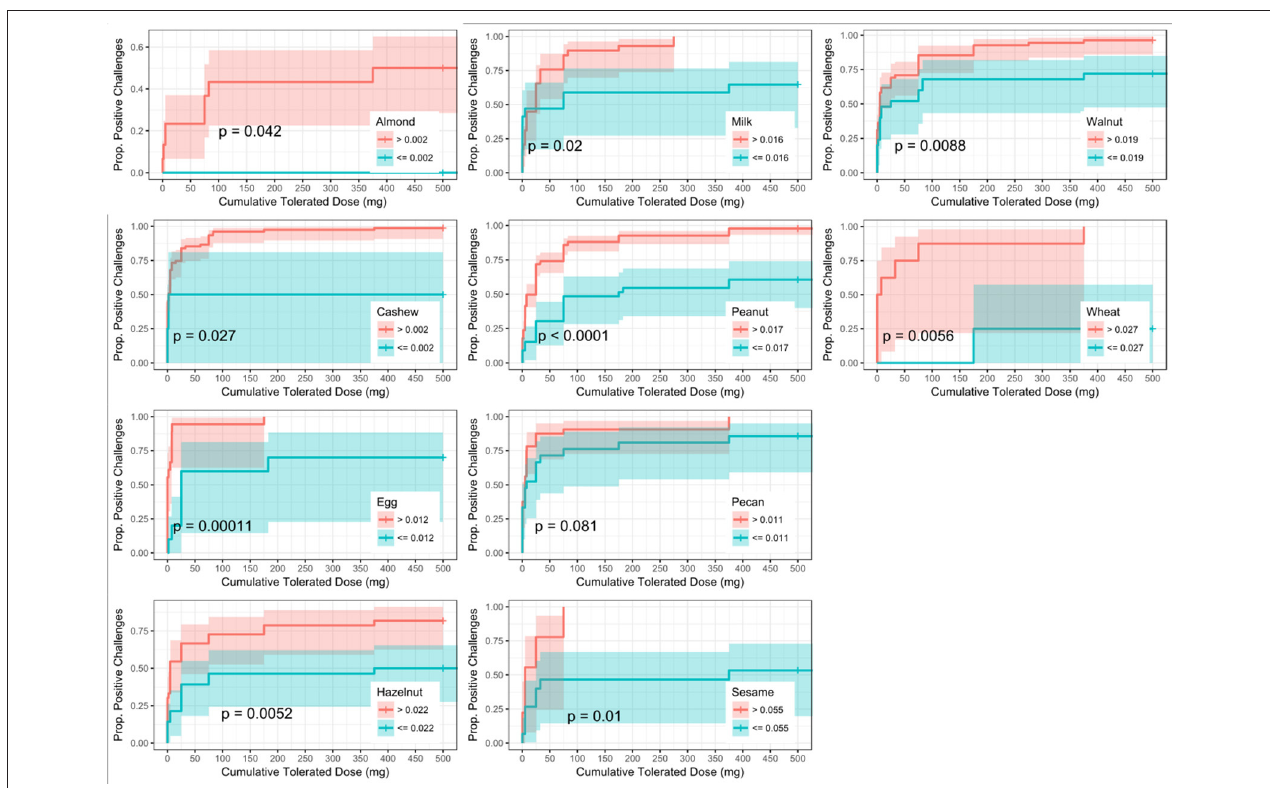
FIGURE 6 | Dose to positive challenge by allergen-specific IgE to Total IgE ratio (sIgEr) threshold and food. Kaplan-Meier curves of dose to positive challenge stratified by the CTD-dependent ROC thresholds for sIgEr by food. Red lines indicate risk of a positive challenge if sIgEr is above the threshold, while blue lines indicate risk for participants with sIgEr at or below the